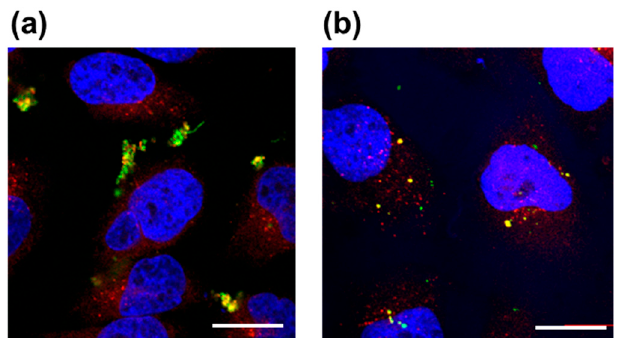
Figure 5. Confocal laser scanning microscopy images of HeLa cells after 4 h treatment with ( a ) P(NIPAAm- co -DMAAm20%)-FL and ( b ) Tyr-P(NIPAAm- co -DMAAm20%)-FL at 40 °C. Fluorescent probes appear green, lysosomes are stained red (LysoTracker Red DND-99), and the nuclei are stained blue (DAPI). Magnification is 40×; the scale bar represents 20 µm.